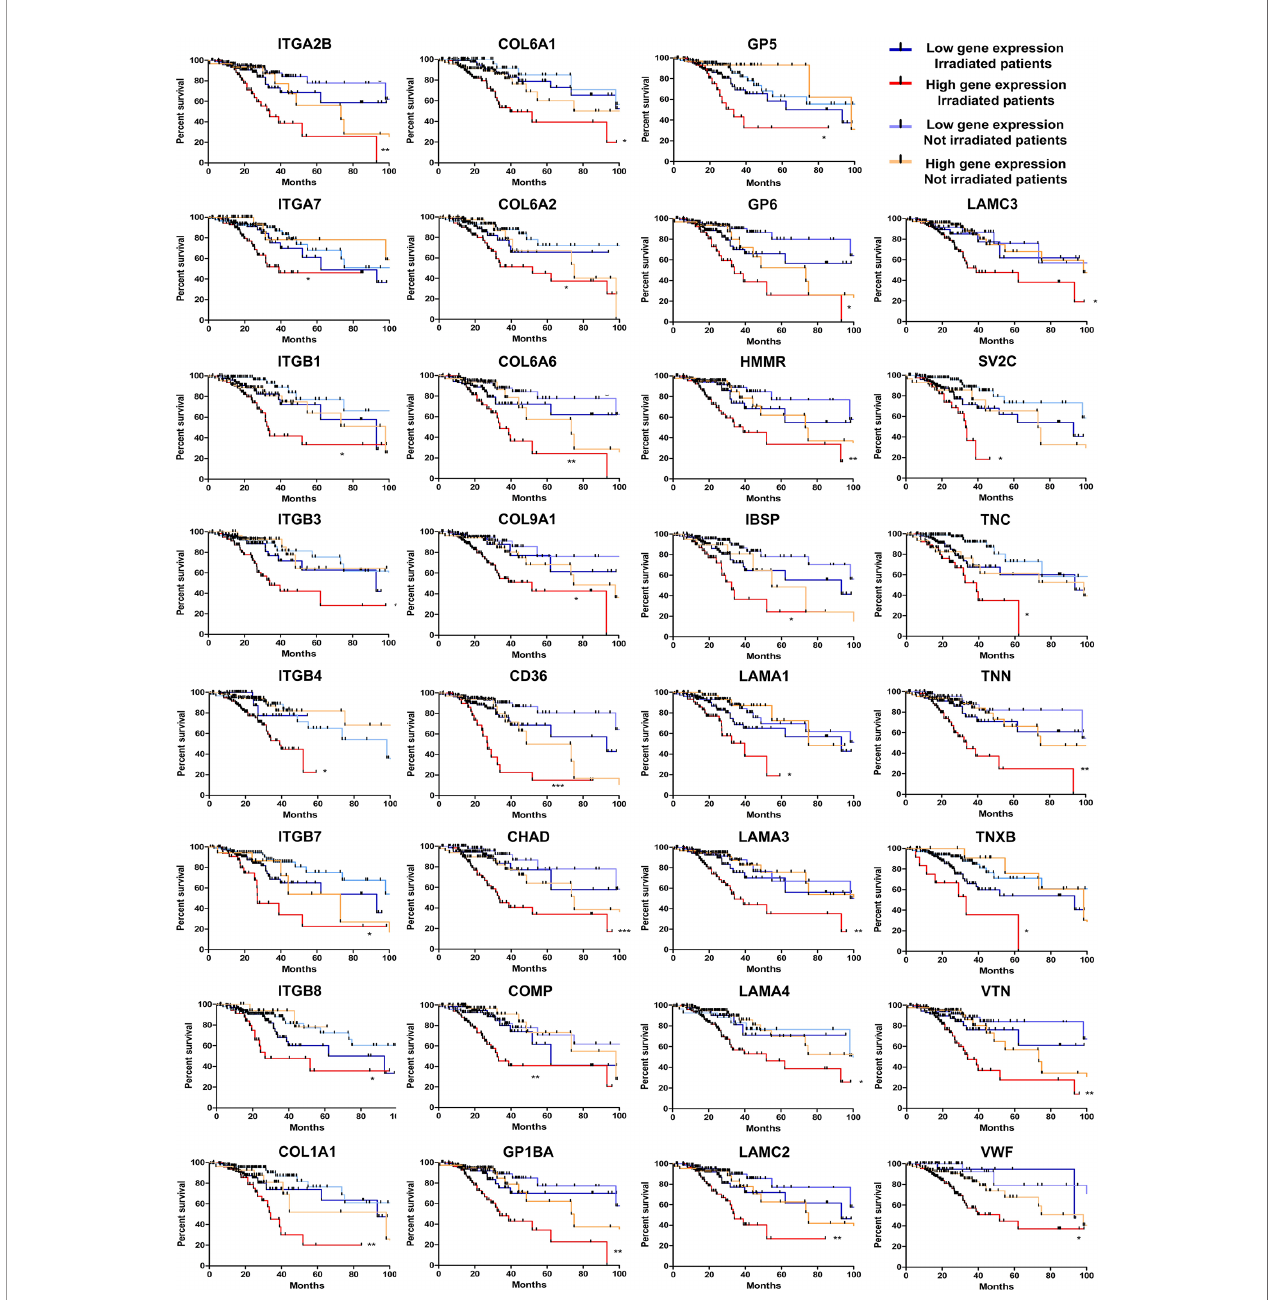
FIGURE 5 | High levels of 31 ECM-receptor interaction transcripts are correlated with poor survival prognosis of radiation-treated patients. Kaplan Meier survival curves for LGG patients according to expression levels of the ECM-receptor interaction genes in the tumors. Patients were divided into four groups: i) untreated patients whose tumors expressed low levels of the analyzed gene; ii) untreated patients whose tumors expressed high levels of the analyzed gene; iii) irradiated patients whose tumors expressed low levels of the analyzed gene; iv) irradiated patients whose tumors expressed high levels of the analyzed gene. *p < 0.05, **p < 0.001, and ***p < 0.0001. The P-values were obtained from a log-rank test. Graphs were plotted with GraphPad Prism 4.0